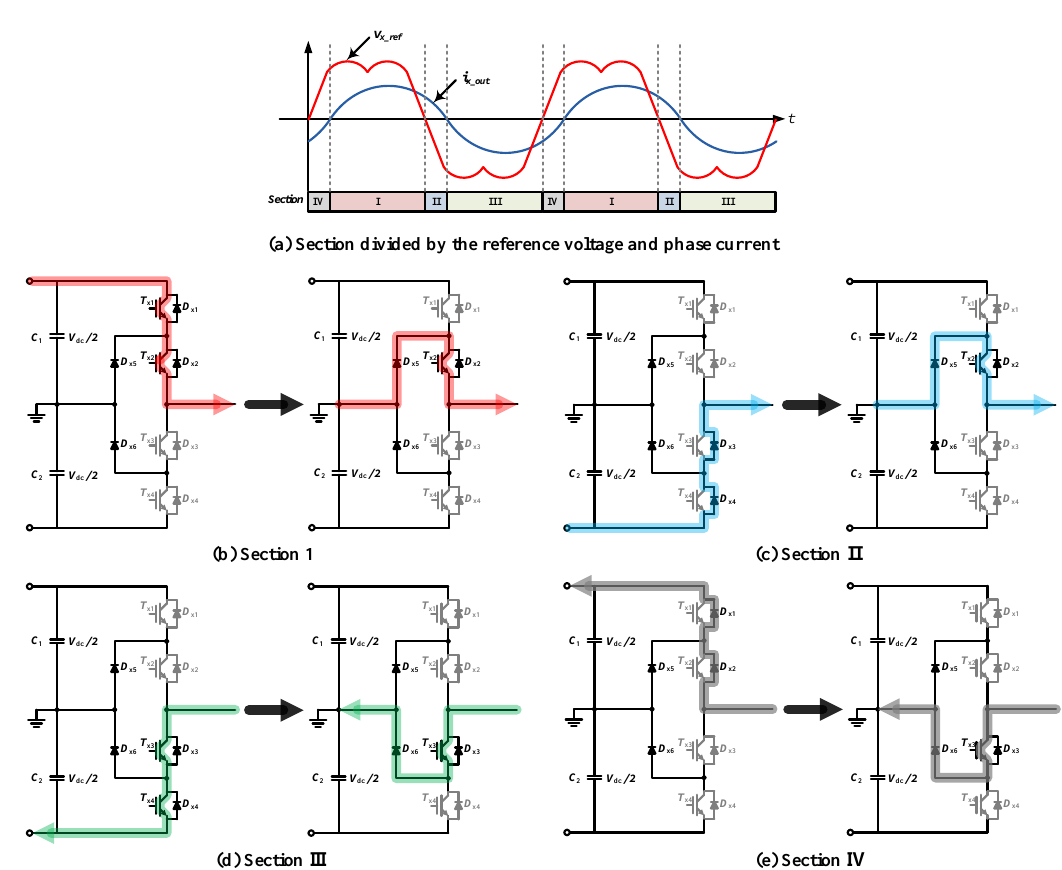
Figure 7. Switching state and current path according to each section divided by the reference voltage and phase current.